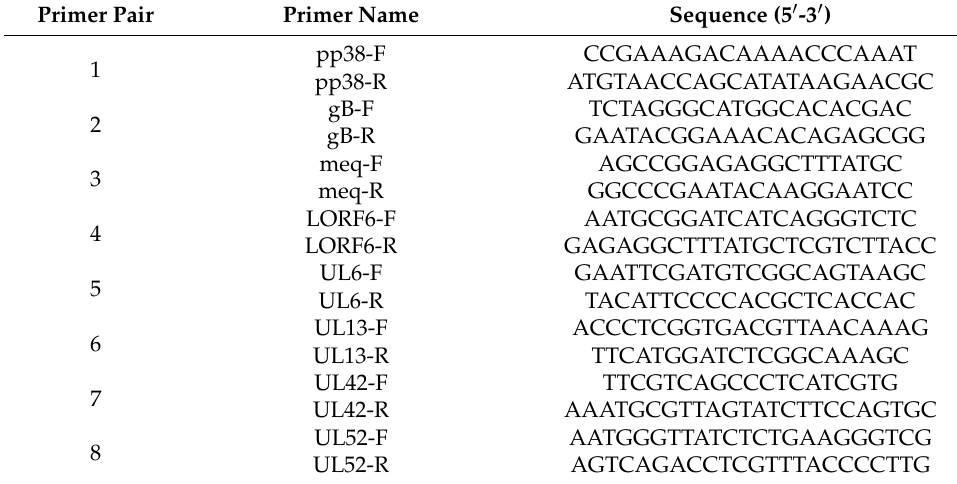
Table 1. Primers used for quantitative RT-qPCR analysis. Primer